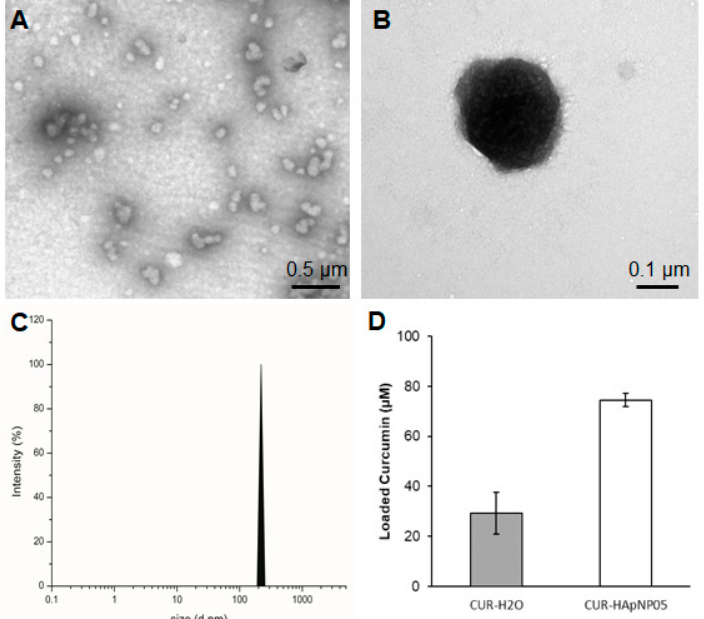
Figure 3. Size, morphology, and loading capacity of CUR-HA-pNIPAM 05 formulation. ( A ) TEM micrograph of CUR-HA-pNIPAM 05 formulation shows that the particles were sized around 100–300 nm. ( B ) A magnified TEM image for a single CUR-HA-pNIPAM 05 nanogel particle; ( C ) DLS results demonstrate the curcumin nanogels in the size range correlated with TEM at PDI = 0.2. ( D ) Loading capacity of the formulation compared to the curcumin in aqueous solution. Scale bars indicate 0.5 µm for ( A ) and for 0.1 µm for ( B ). The values expressed in ( D ) are means ± SD, n = 3.